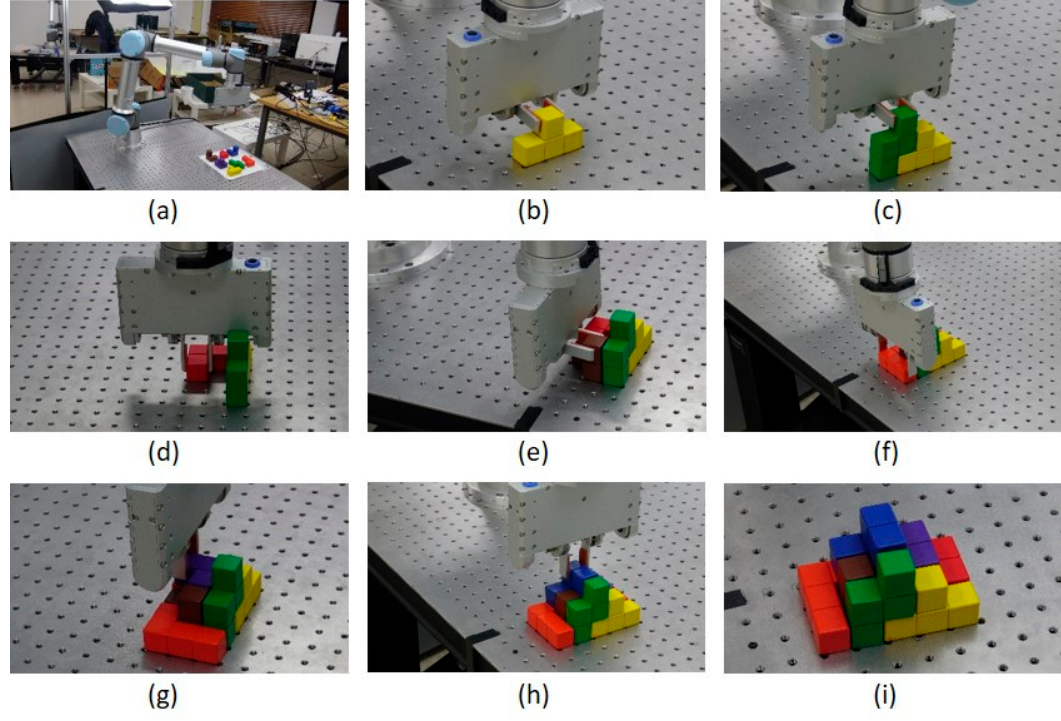
Figure 11. Soma puzzle assembly in formation 3 (shown in ( i )). From ( a – h ) the figures show the snapshots of the assembly poses of the gripper and part during the assembly process.